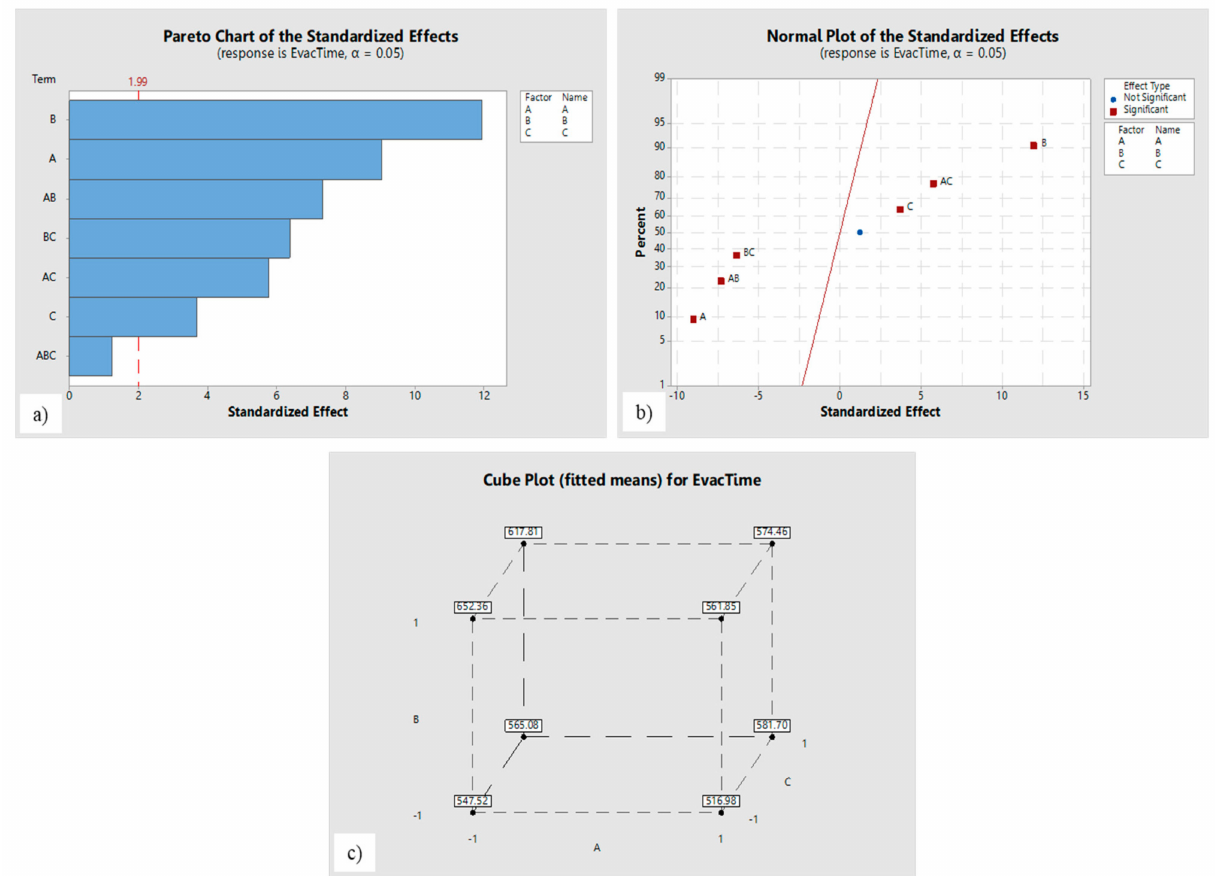
Figure 8. Analysis of factorial design with ( a ) Pareto chart ( b ) normal plot ( c ) cube